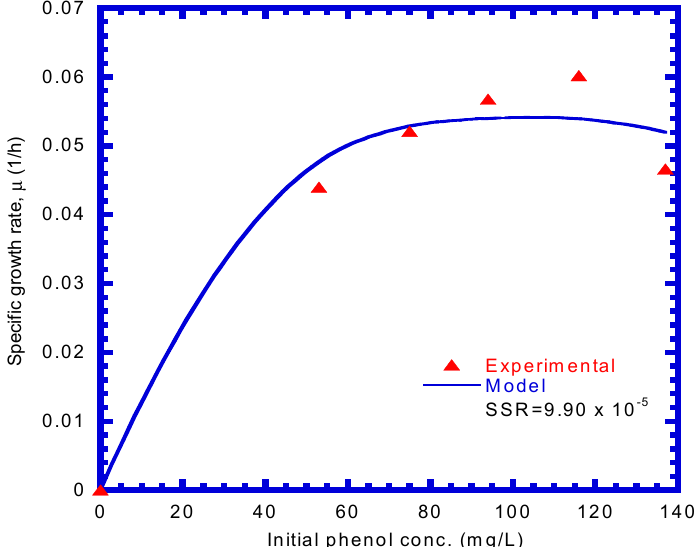
Figure 4. Comparison of experimental and modeling data to estimate the maximum specific growth rate ( μ m ), saturation constant ( K S ), and inhibition constant ( K I ). μ m = 0.15 1/h, K S = 87.5 mg/L, and K I = 111.6 mg/L.